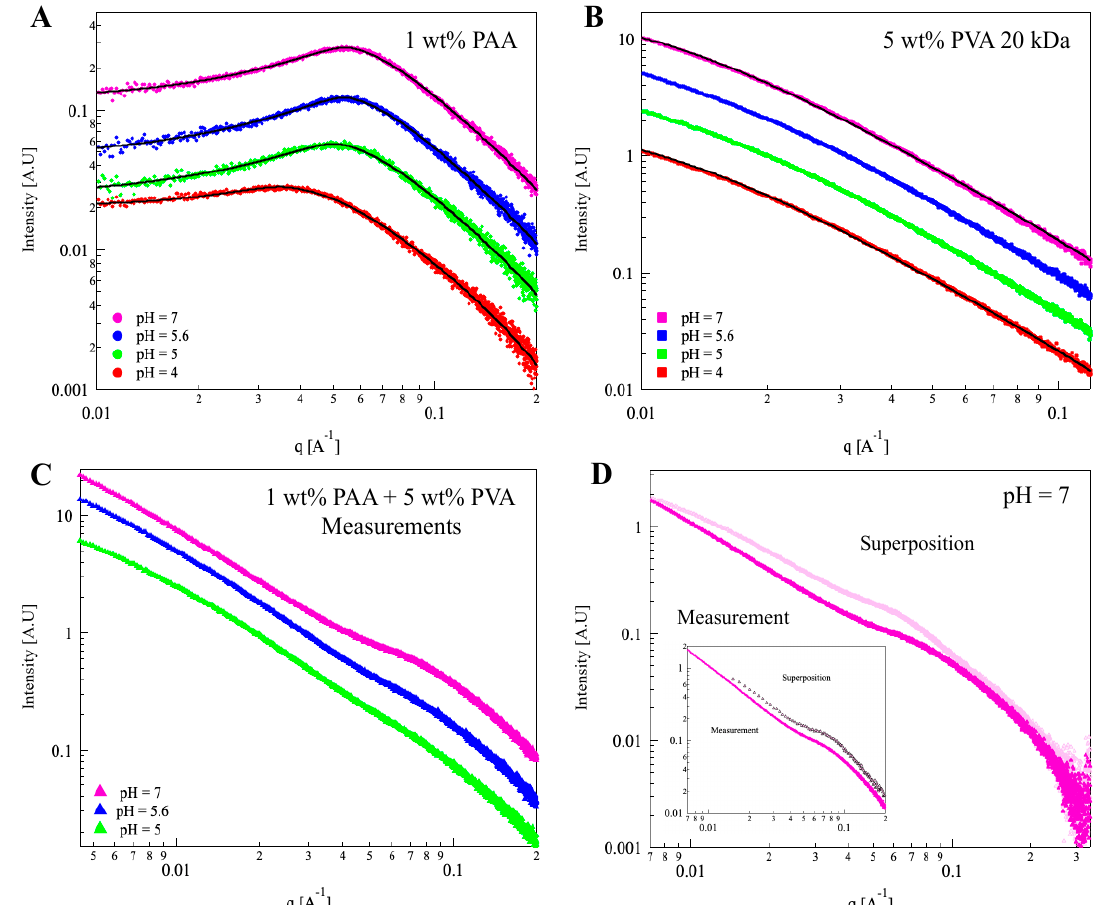
Figure 4. SAXS measurements. One-dimensional SAXS curves obtained from ( A ) 1 wt% PAA 100 kDa solutions, ( B ) 5 wt% PVA 20 kDa solutions, and ( C ) 1 wt% PAA-5 wt% PVA mixtures at pH = 4, 5, 5.6, 7. The solid black lines represent the best fit to Equations (S2)–(S4) (described in detail in the ESI) ( D ) Measured ( ▲ ) and calculated via superposition ( ▲ ) 1D SAXS curves obtained from 1 wt% PAA in 5 wt% PVA at pH = 7. Inset: SAXS curve obtained from 1 wt% PAA in 5 wt% PVA solution at pH = 7 (▲) and calculated curve via superposition of 1.6 wt% PAA and 5 wt% PVA at pH = 7 (▲). The curves are shifted for better visualization. Color bar: pH = 4 ( ▼ ), 5 ( ▼ ), 5.6 ( ▼ ), 7 ( ▼ ). The scattering curves of 1 wt% PAA in solutions of 5 wt% PVA at different pH